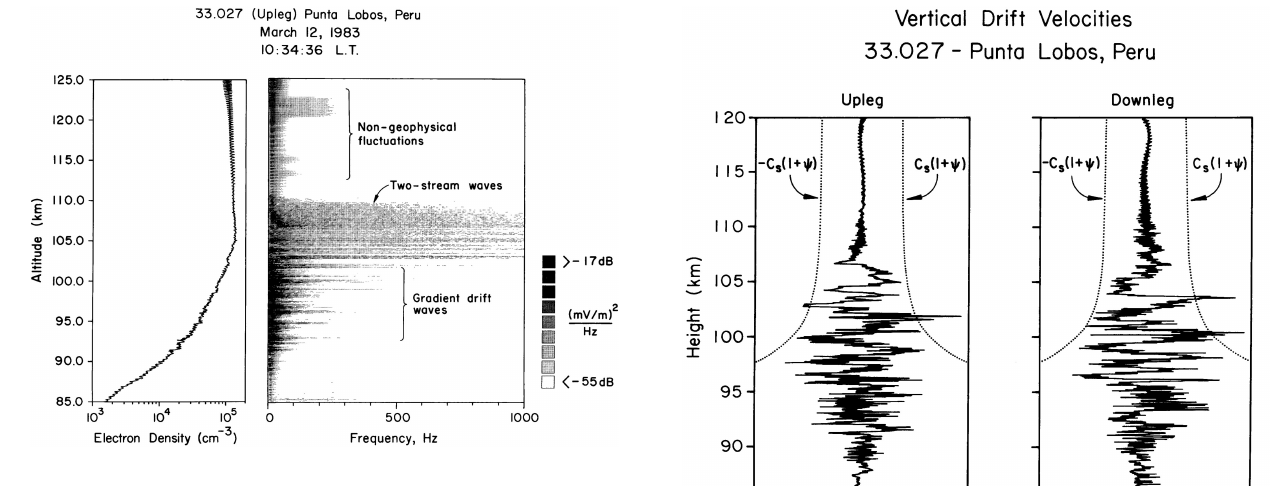
Fig. 5. Rocket observations of density gradients and wave activ- ity. The waves change character where the profile flattens out (from Pfaff et al., 1987a).